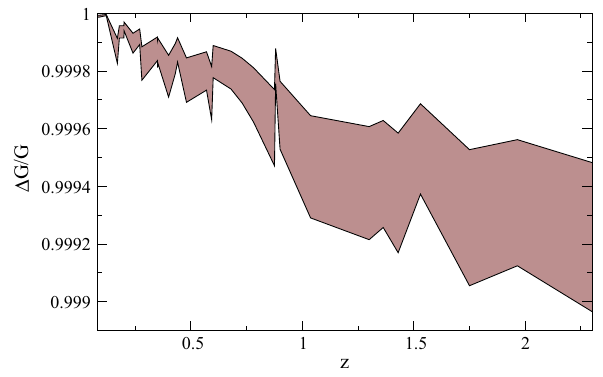
Fig. 6 The relative variation (cid:7) G / G as a function of the redshift. We display the ( shaded ) region comprised in between the fit values ν G ∈ [ 0 . 0005 ; 0 . 001 ] , which encompass the typical parameter range